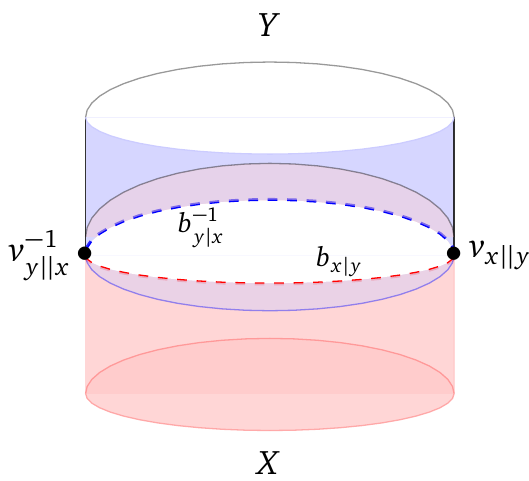
Figure 1: The two domed cylinders in red and blue represent two objects X , Y ∈ C respectively, living in four dimensions. The purple coloured regions show the domes of the objects. Initially, we can think of one object being above the other. The dashed lines indicate places where the two sheets pass over each other in the fourth dimen- sion, with the colour indicating which is above. The two marked points show where one of the surfaces crosses over the other in the fifth dimension, changing the order of which surface is above and below. The change in color of the dotted circle repre- sents the fact that after the syllepsis, the object which was initially on top, is now on the